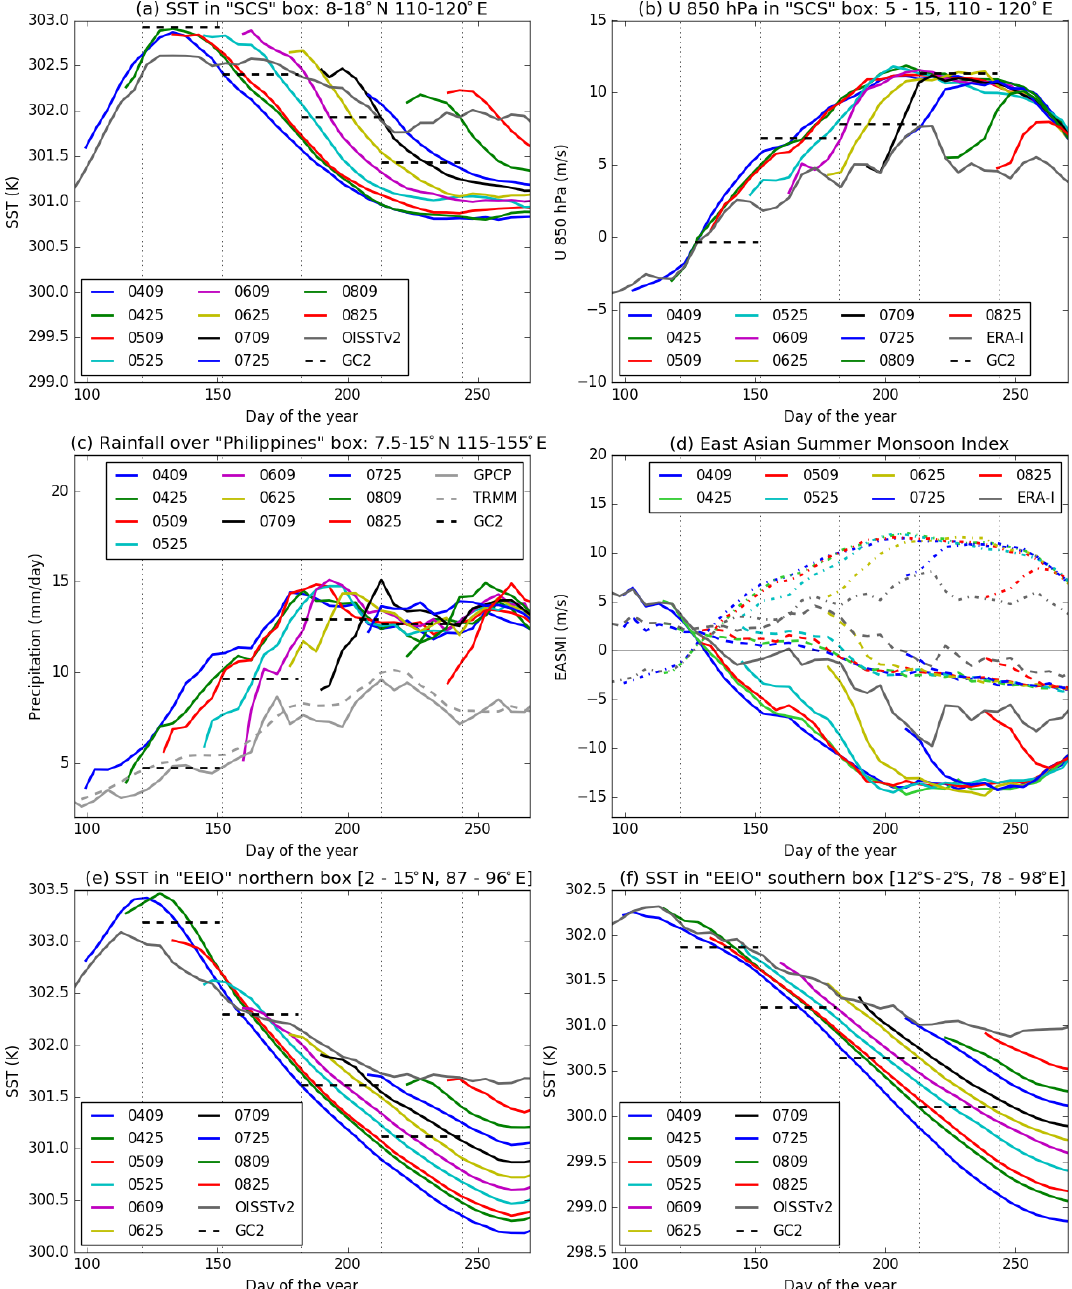
Figure 8. Climatological spin-up of various quantities over key regions in GloSea5 hindcast ensembles initialised on 9, 25 April (0409, 0425), 9, 25 May (0509, 0525), 9, 25 June (0609, 0625), 9, 25 July (0709, 0725), 9, 25 August (0809, 0825), seven members for each, averaged over 1993–2015: (a) SST in South China Sea (8–18 ◦ N, 110–120 ◦ E); (b) 850hPa zonal wind over SCS box used by Wang et al. (2004) (5–15 ◦ N, 110–120 ◦ E); (c) rainfall over the Philippines box (7.5–15 ◦ N, 115–155 ◦ E); (d) EASMI: 850hPa zonal wind difference (22.5–32.5 ◦ N, 110– 140 ◦ E) – (5–15 ◦ N, 90–130 ◦ E); (e) SST in EEIO northern box (2–15 ◦ N, 87–96 ◦ E); (f) SST in EEIO southern box (12–2 ◦ S, 78–98 ◦ E). Pentad SST is shown from OISSTv2, pentad rainfall from GPCP and TRMM observations and EASMI from ERA-I. For EASMI, the solid lines indicate the index, while the dashed line indicates the northern box and the dot–dash line indicates the southern box. Horizontal dashed black lines indicate monthly averages from free-running GC2 coupled model simulations. Day of the year is calculated using the Gregorian calendar (without leap years); day 121 corresponds to 1 May. Vertical dotted lines indicate the start of each month.